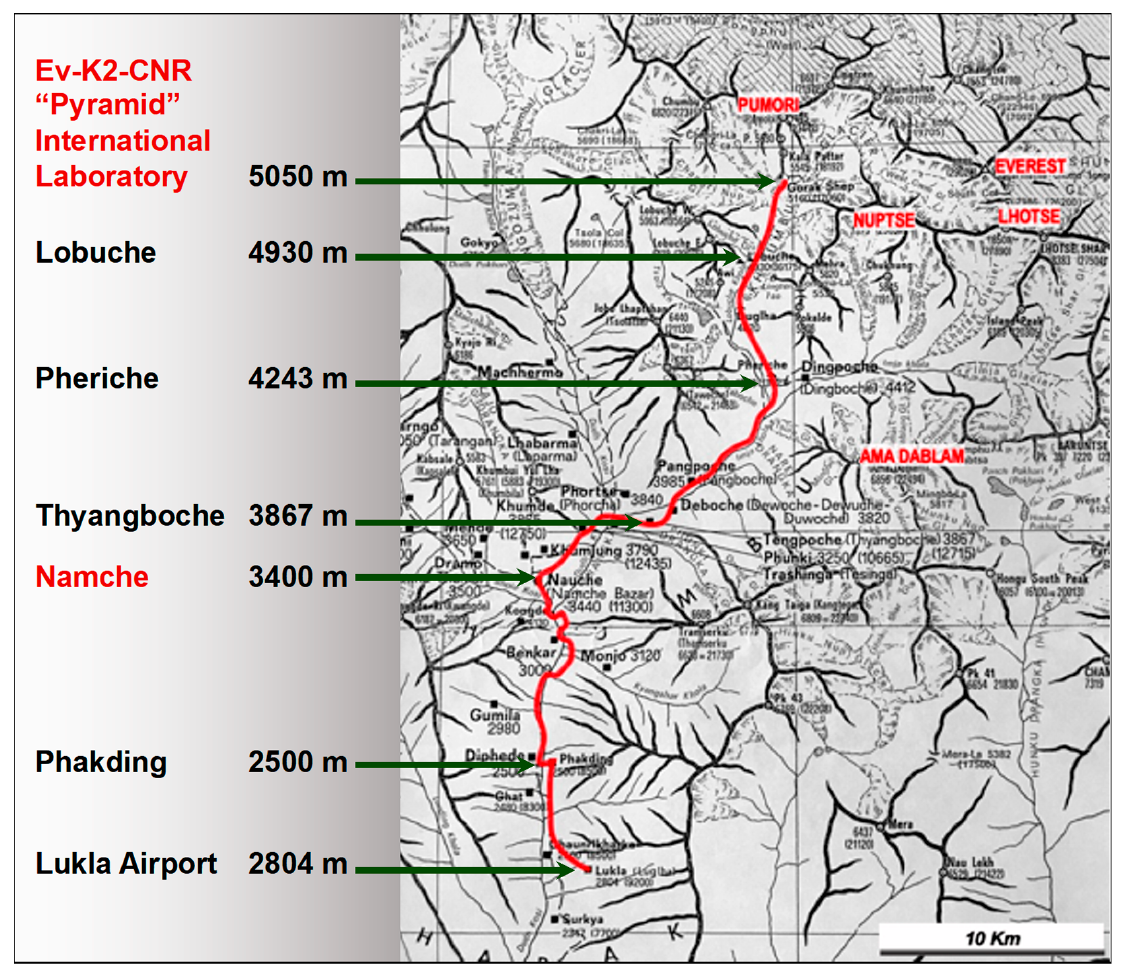
Figure 1. Trekking from Lukla airport (2804 m above sea level) to the international high-altitude research laboratory Ev-K2-CNR, “Pyramid” (5050 m a.s.l.). The tests were performed in Namche Bazar (3400 m a.s.l.) and at the “Pyramid” laboratory. Nepalese highlanders were studied on the same day as Europeans at 3400 m